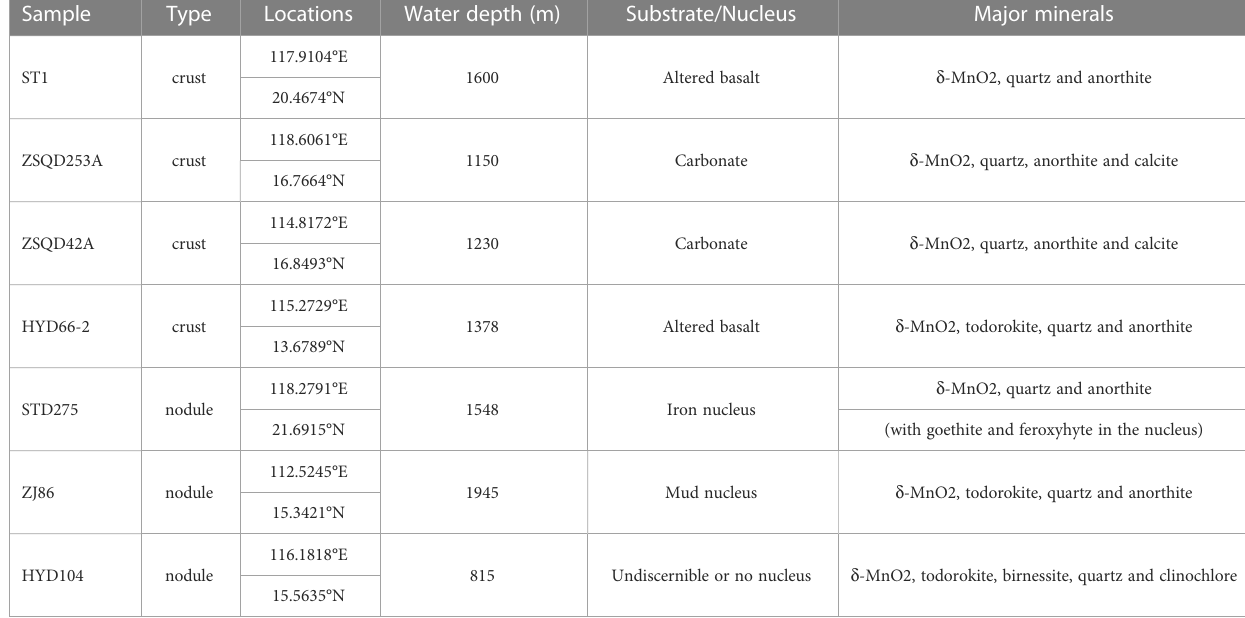
TABLE 1 Sample descriptions and bulk mineralogy of Fe-Mn crusts and nodules from the South China Sea.